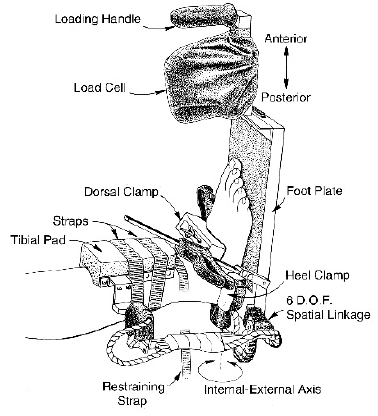
Figure 1. Ankle Figure 1. Ankle arthrometer.